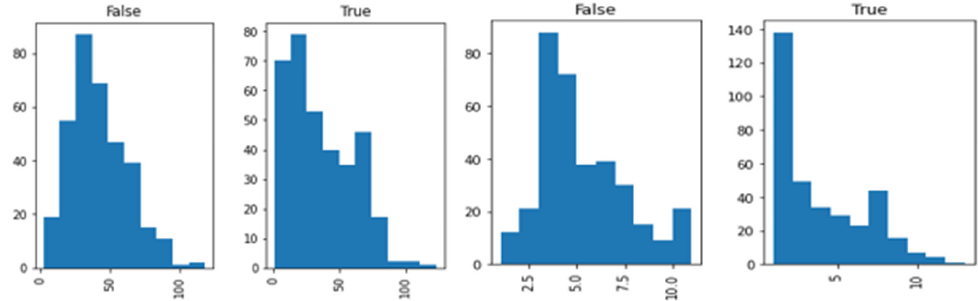
Figure 3. Word ( left ) and Sentences ( right ) distribution, grouped by sarcasm.